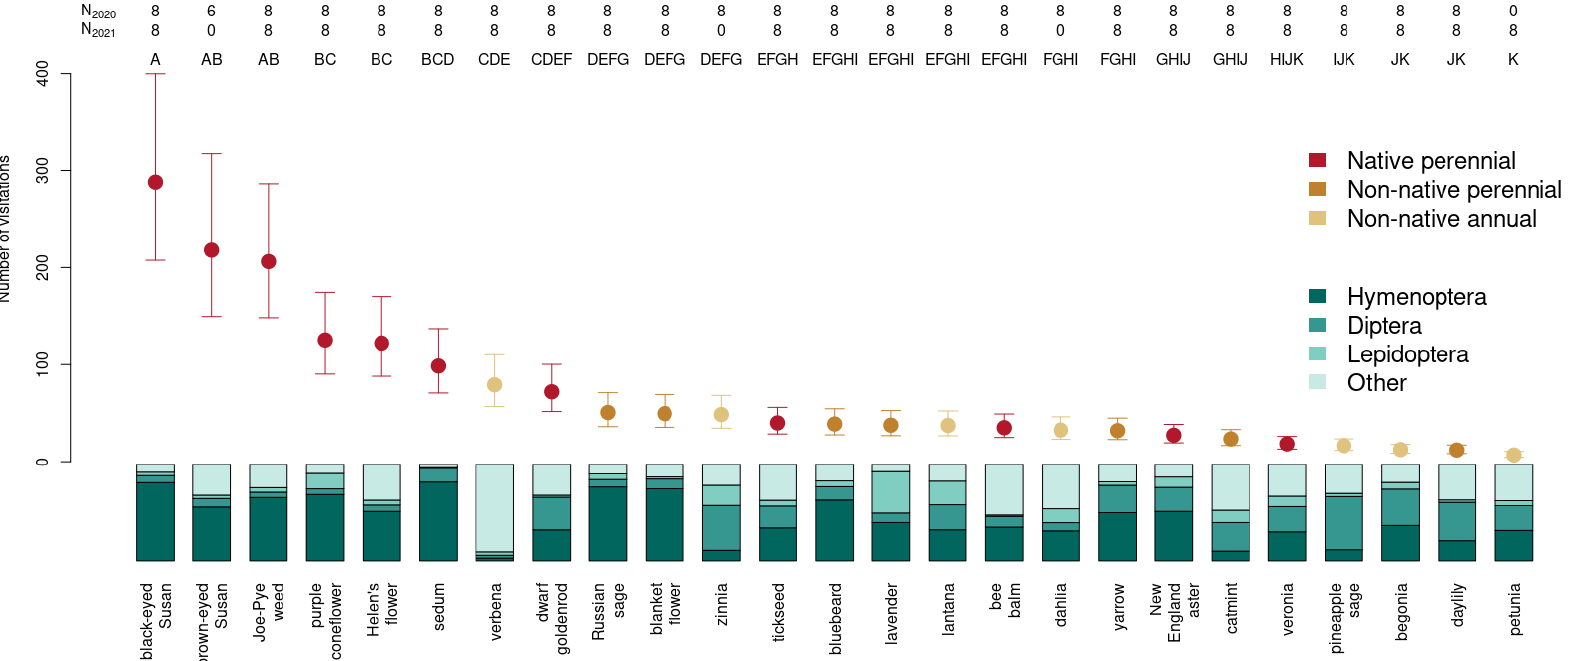
Figure 3. Ornamental plants significantly impact the abundance of insect visitors. The x axis displays the ornamental plants in our study, and the y axis represents the abundance, seen as annual total number of visitors per plant plot, averaged (95% CI) across plots. Post hoc mean separation test results are displayed as letters on top of the figure, and color bars at the bottom represent proportional abundance for three classes (plus “other”) of insect visitors. Datapoint colors denote whether the plant was a native perennial, non-native perennial, or non-native annual.